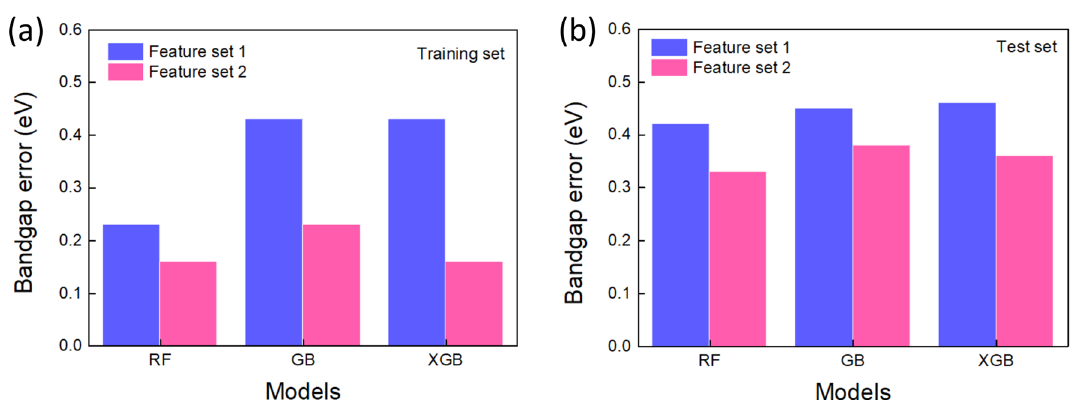
Figure 3. Bar plots of the MAE errors generated by the feature sets 1 and 2. The results are grouped into the training set ( a ) and the test set ( b ) to highlight the out-performance of the ML inference when using the additional features (set